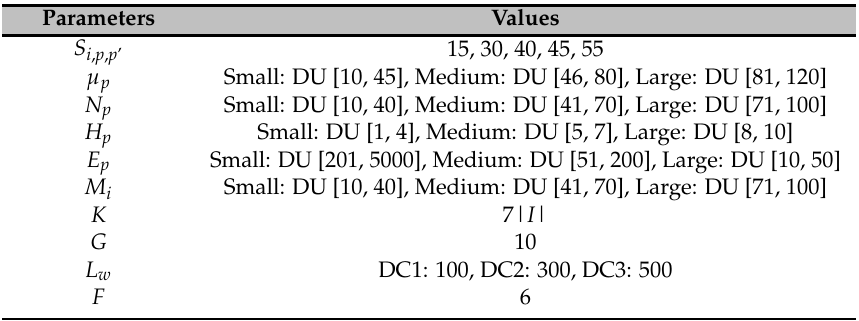
Table 3. Other experimental parameter